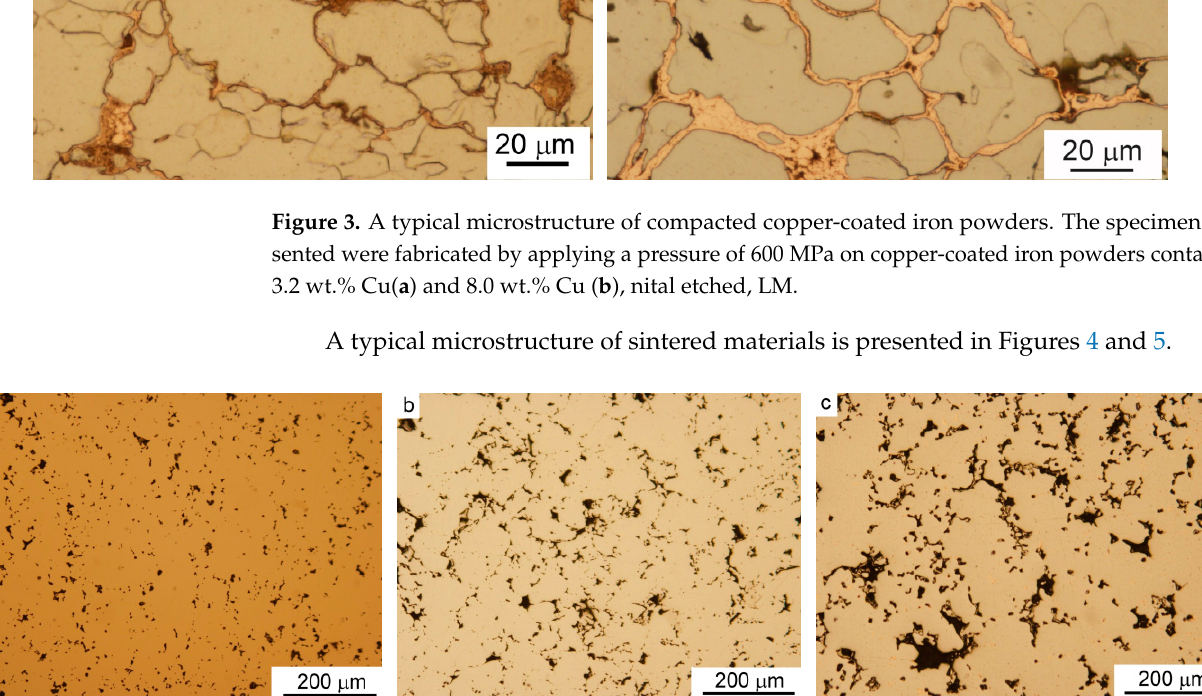
Figure 4. Pores in sintered materials: ( a ) Fe, ( b ) Fe-3.2 wt.% Cu, and ( c ) Fe-8.0 wt.% Cu, LM.